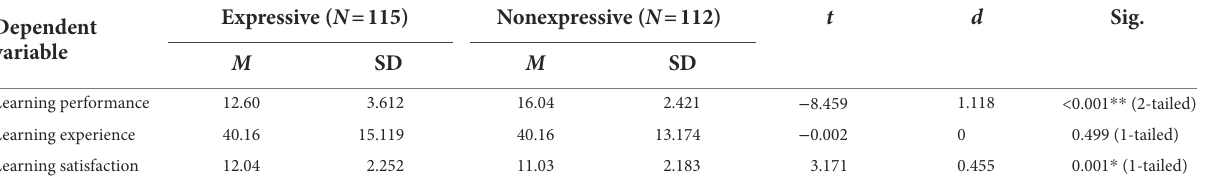
TABLE 2 The descriptive statistics for dependent variables in experiment 1. Expressive ( N = 115) Dependent variable